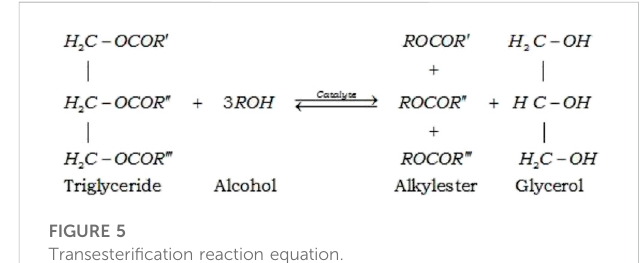
FIGURE 5 Transesteri fi cation reaction